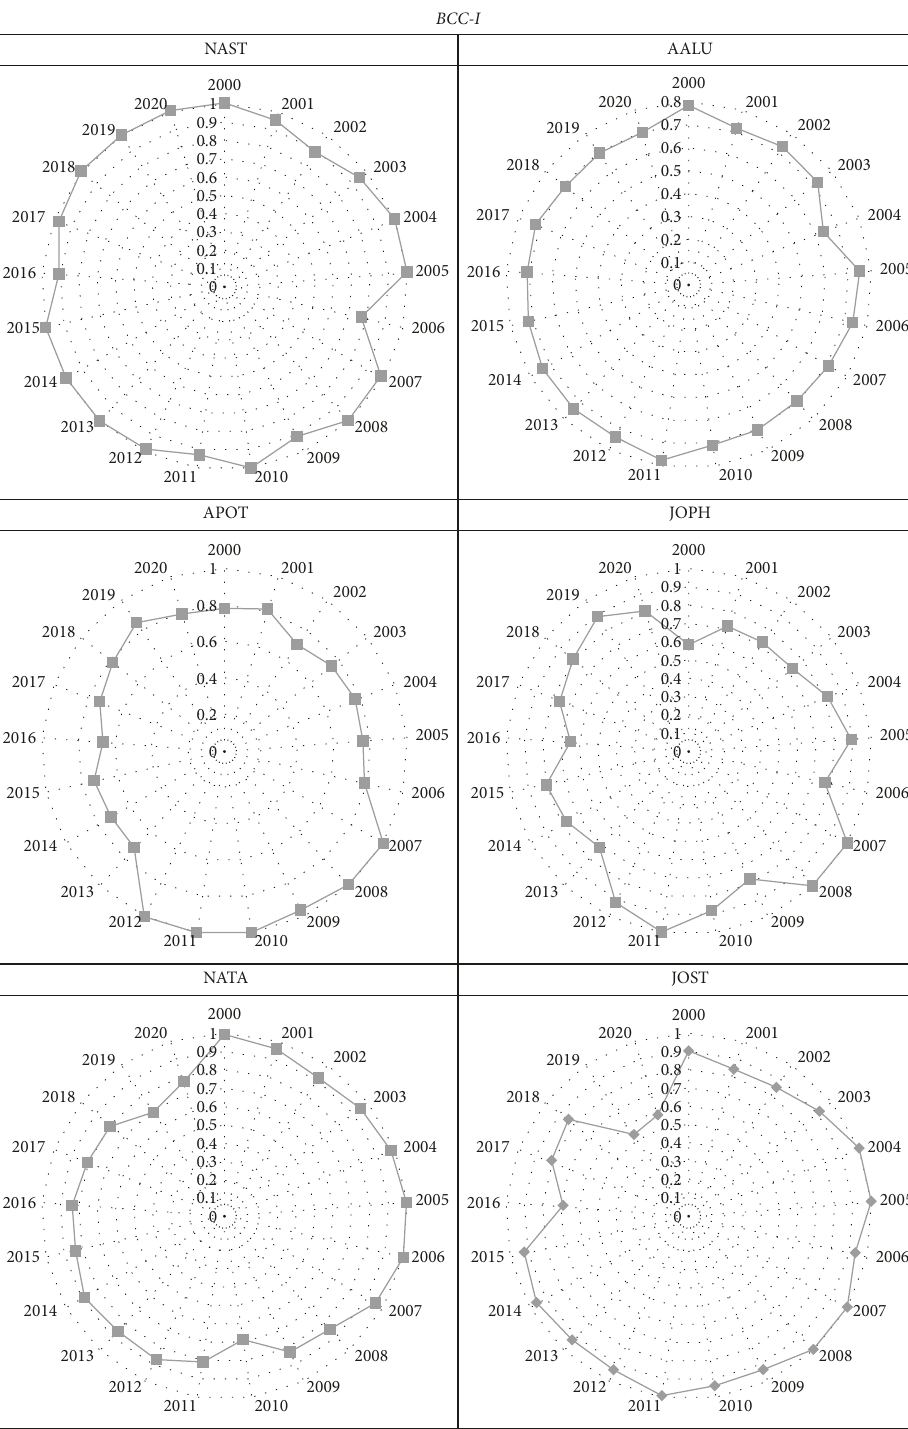
Figure 1: The efficiency rate for each company of BCC-I model during